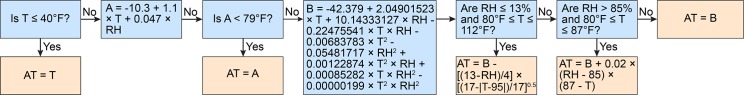
Flowchart for calculating apparent temperature (in °F).Temperature (T) is in degrees Fahrenheit and relative humidity (RH) is in percent. The flowchart is based on previous representations of the equations used to calculate the heat index [33,35].